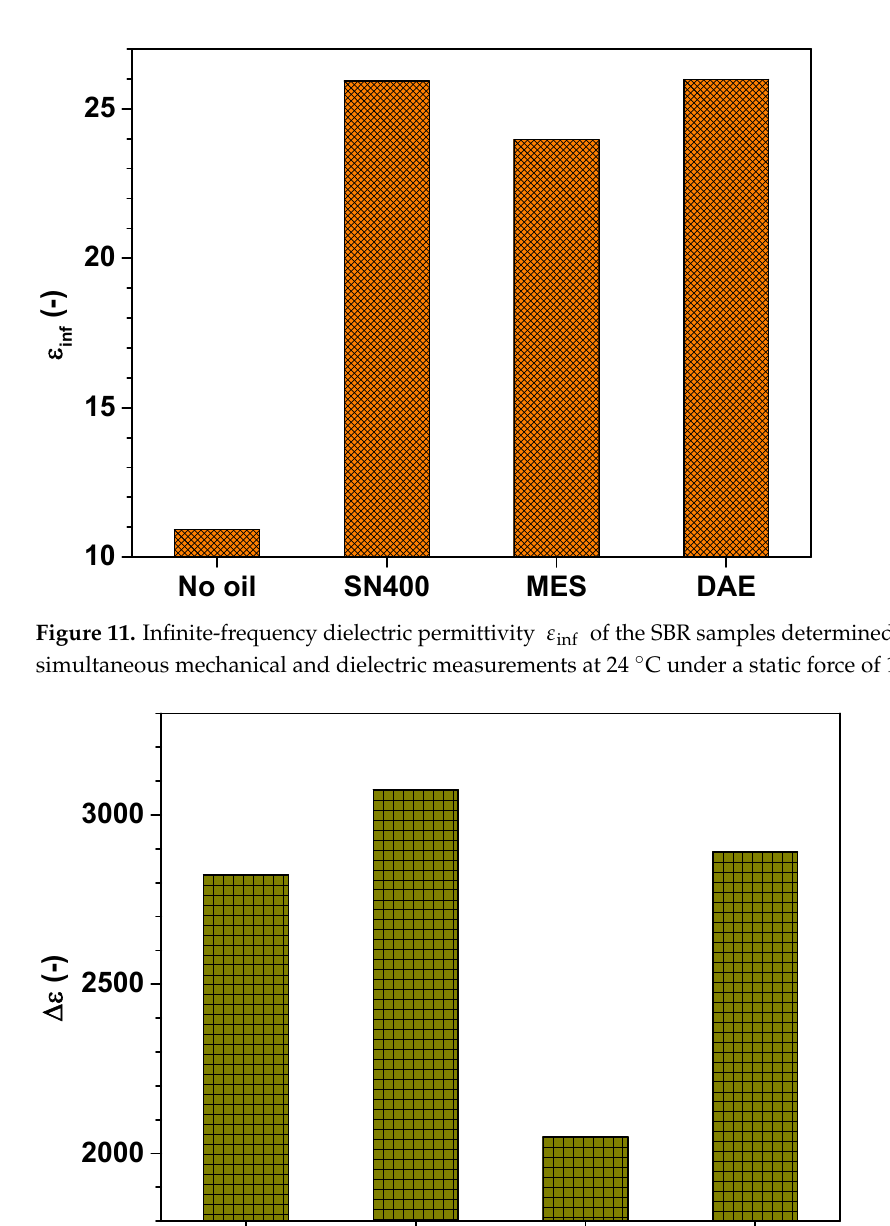
Figure 12. Relaxation strength ∆𝜀 of the SBR samples determined by means of simultaneous mechanical and dielectric measurements at 24 °C under a static force of 10 N.